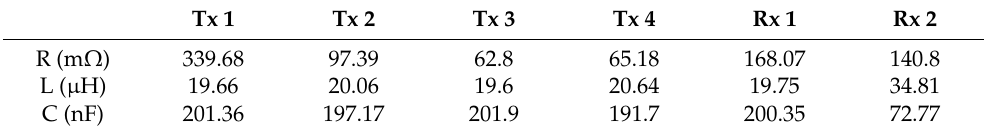
Figure 6. Configuration of Tx coils and Rx coils. Table 1. Specifications for all